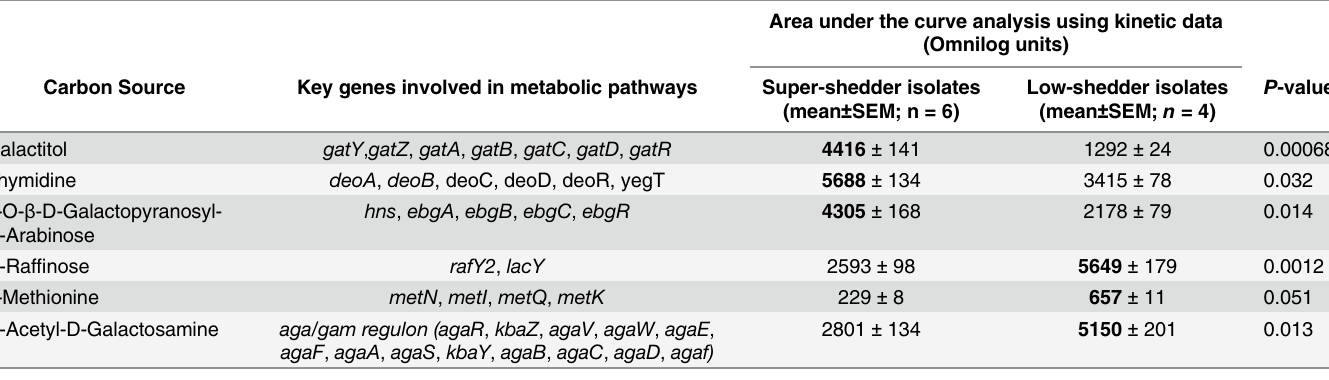
Area under the curve analysis using kinetic data (Omnilog units)